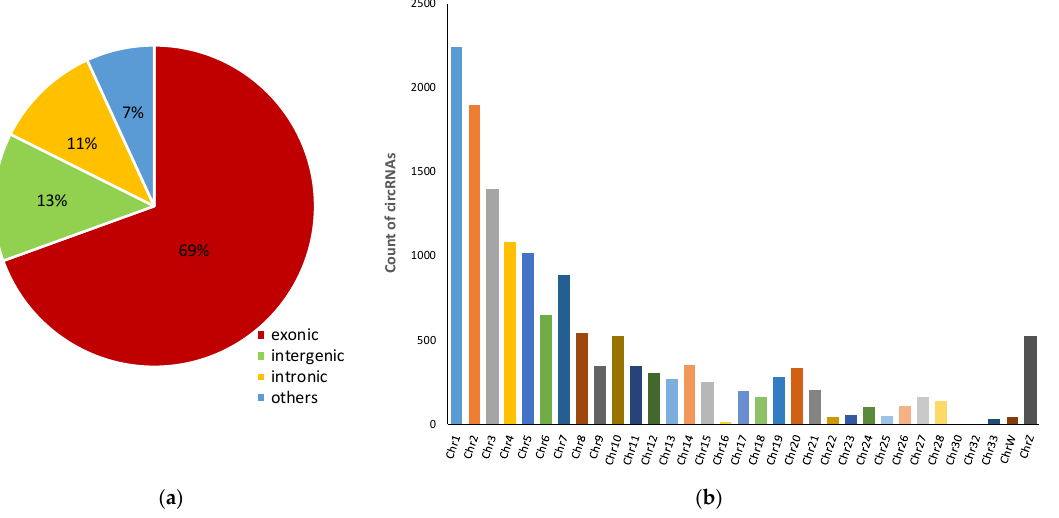
Figure 1. Characteristics of circRNAs. ( a ) Breakdown by circRNA type; ( b ) chromosome distribution of all identified